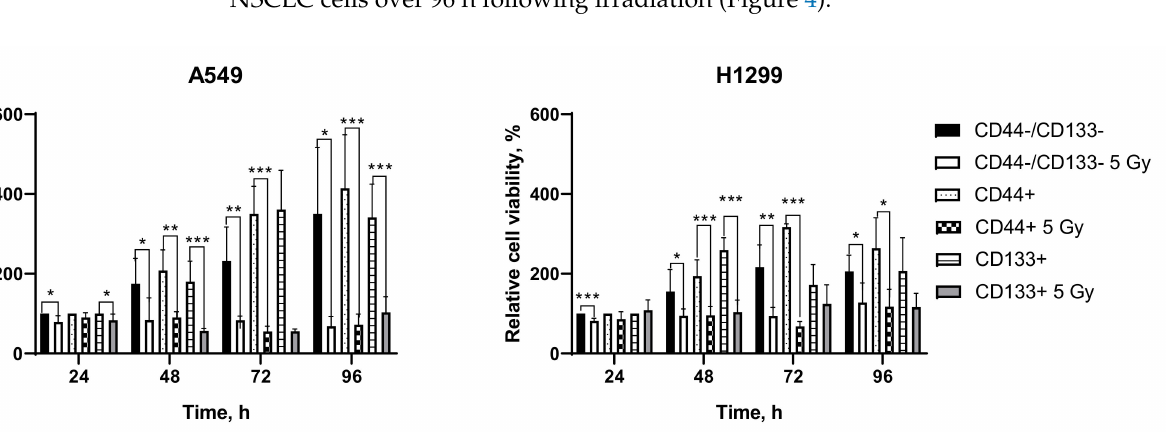
Figure 4. Assessment of cell viability using the metabolic MTT assay of the glycolytic NAD(P)H production at different times after IR at 5 Gy. * denotes significant differences at * p < 0.05; ** p < 0.01; *** p <